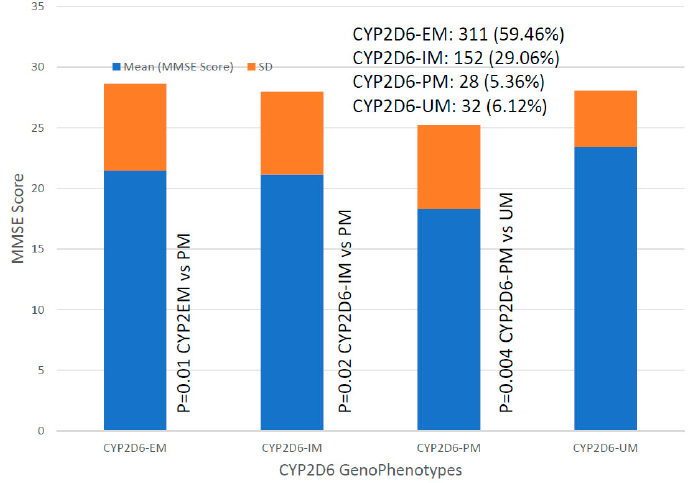
Figure 17. CYP2D6 GenoPhenotype-related mental performance (MMSE score) at diagnosis in Alzheimer’s disease.